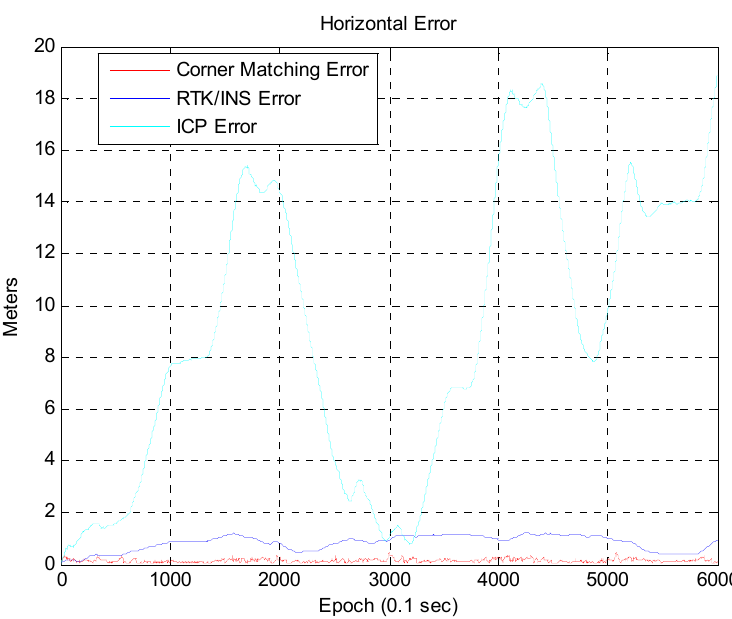
Figure 16. Position error (using only the ICP based DR).